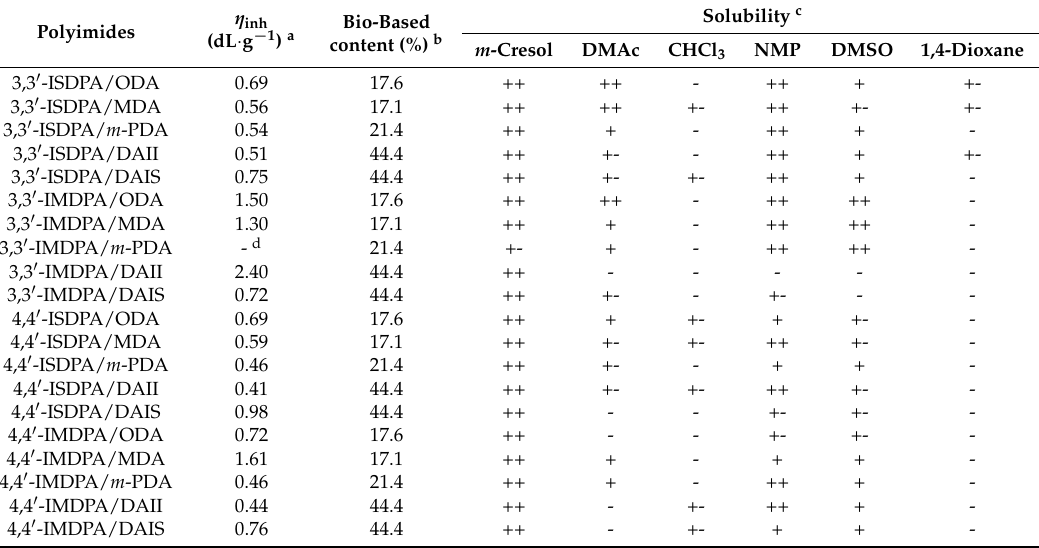
Figure 4. Representative 1 H NMR spectra of isohexide-derived PEIs in DMSO- d 6 . ( a ): 4,4′- ISDPA/ODA; ( b ): 3,3′-ISDPA/ODA; ( c ): 4,4′-IMDPA/ODA; ( d ): 3,3′-IMDPA/ODA. 3.3. Properties of Bio-Based Poly(Ether Imide)s 3.3.1. Bio-Based Contents and Solubility In the present work, the bio-based content is defined as the percentage of organic carbon coming in the product from the bio-renewable feedstocks [48]. For bio-based PEIs, the carbons in isohexide segments were of bio-based origin, whereas the carbons in phthalimide and aromatic diamine residues were based on petrochemicals. As listed in Table 1, the bio-based contents for isohexide- derived polyimides were found to be lying within the range of 17.1–44.4%. In particular, the polyimides with isohexide moieties in both the dianhydride and the diamine residues possessed the bio-based content of 44.4%, which was markedly higher than the minimum requirement (25%) for bio-based materials suggested by USDA [50]. The solubility of isohexide-derived PEIs was tested in various solvents, and the results are presented in Table 1. All the polymers exhibited good solubility in m -cresol and NMP, while their solubility in low boiling solvents (chloroform and 1,4-dioxane) were found to be very limited. For a given dianhydride, PEIs based on DAII and DAIS showed lower solubility compared to those based on aromatic diamines. This can be ascribed to the incompatibility between the polar solvents and the nonpolar isohexide moieties. For certain diamines and catenation positions of phthalimide segments, the solubility of PEIs containing isosorbide residue was similar to that of the polyimides having isomannide residue. Moreover, 3,3′-linked polyimides showed higher solubility than 4,4′-linked polyimides due to their more bent structures, which loosened the chain packing, and hence increased the solubility.